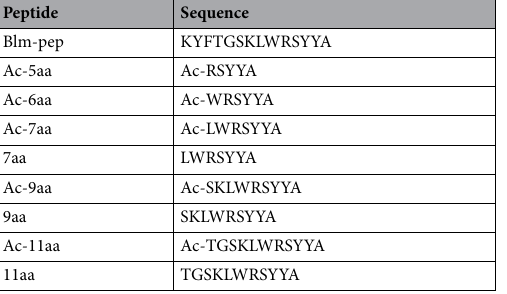
Table 1. Sequences of Blm-pep and its shorter analogs. MS data are included in Supplementary Table 1S.